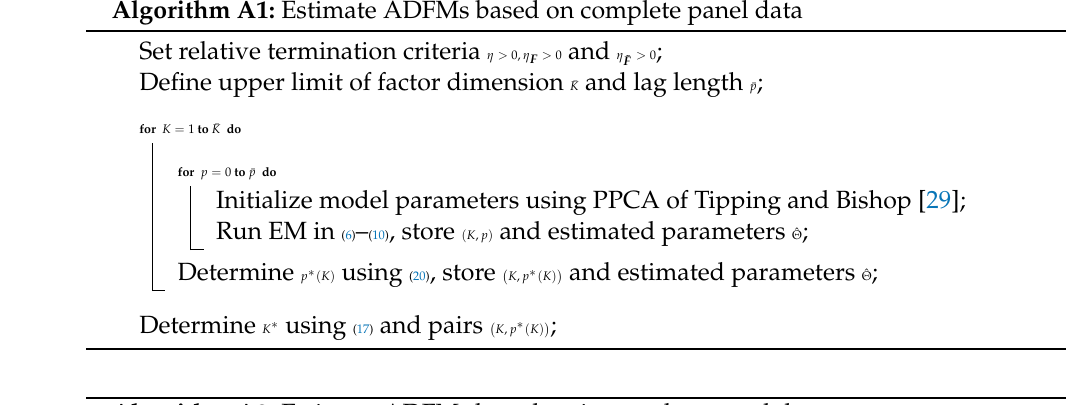
Algorithm A2: Estimate ADFMs based on incomplete panel data